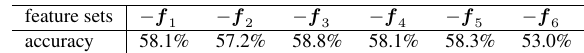
Figure 3: Accuracy of each class on each feature set, with each class is normalized to 100. Table 5: Average accuracy of RDF classifier on the feature sets. Feature sets − f mean the rest of all 6 feature sets except f i used, i = 1 , · · · , 6 .